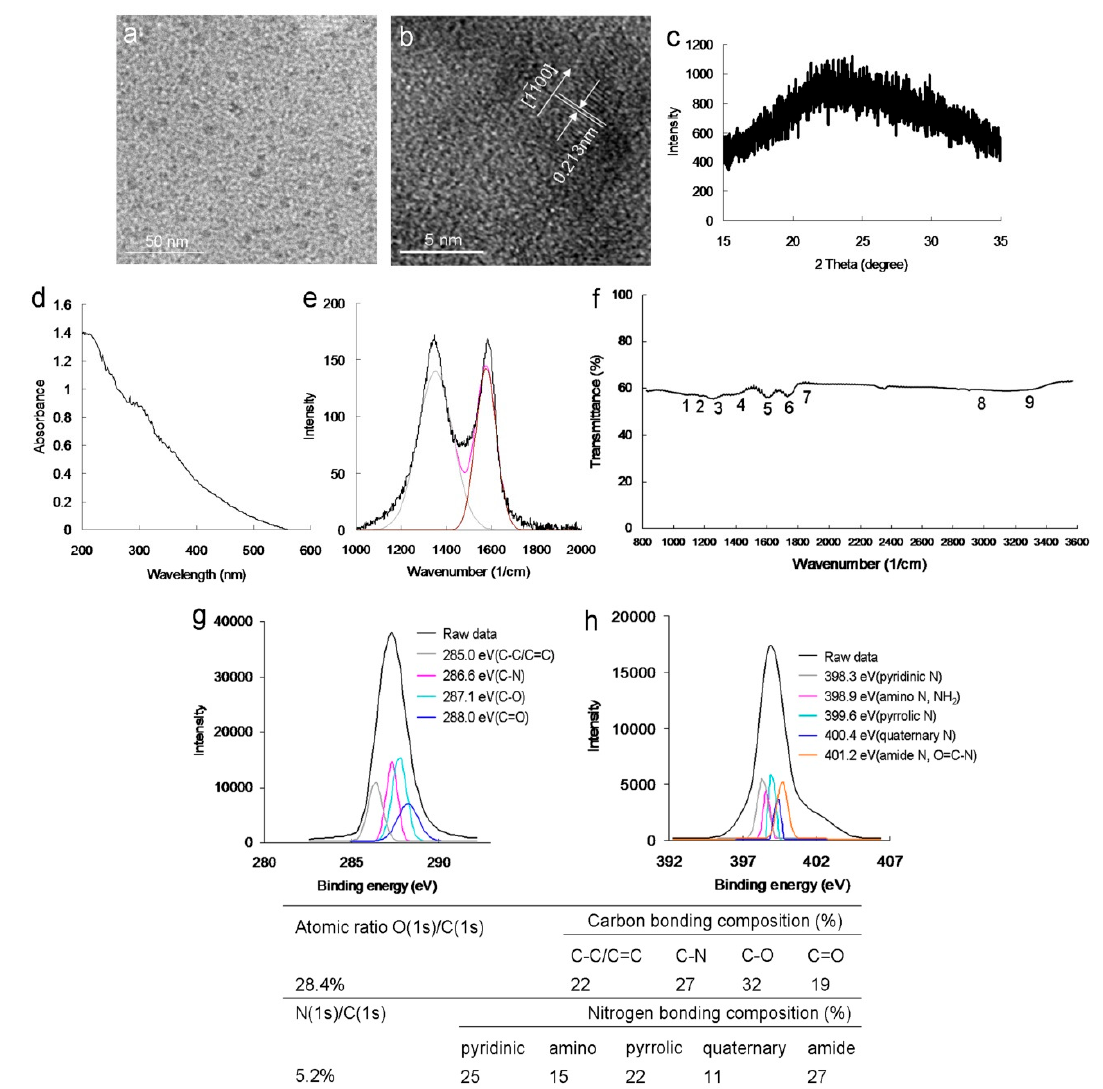
Figure 1. ( a ) Low-magnified transmission electron microscopy (TEM) image; ( b ) High-resolution (HR) TEM image captured for a single amino-N-graphene quantum dot (GQD) (mean lateral size = ~8.3 nm; interlayer spacing = 0.213 nm); the size distribution of its histogram was determined using dynamic light scattering (DLS) (Figure S1a). ( c ) X-ray diffraction (XRD) pattern of amino-N-GQDs. ( d ) Raman spectrum of amino-N-GQDs, with the gray and brown lines representing the spectrum decomposed and fitted to the D- and G-band peaks (at ~1384 and 1606 cm − 1 , respectively; black line: raw data; pink line: decomposed spectrum). ( e ) Ultraviolet-visible (UV-vis), and ( f ) Fourier-transform infrared (FTIR) spectra of amino-N-GQDs. ( g , h ) X-ray photoelectron spectroscopy (XPS) spectrum of amino-N-GQDs obtained to determine the changes in the chemical state. In the deconvoluted C(1s) spectrum, the peaks were fitted using the Gaussian function corresponding to C–C/C=C, C–N, C–O, and C=O. In the deconvoluted N(1s) spectrum, the peaks were fitted using the Gaussian function corresponding to pyridinic N, amino N, pyrrolic N, quaternary N, and amide N. The table summarizes the bonding composition and atomic ratio of the amino-N-GQDs. The O(1s)/C(1s) and N(1s)/C(1s) atomic ratios were 28.4% and 5.2%, respectively. Delivered dose: 0.5 μ g·mL − 1 to 5 mg·mL − 1 material.